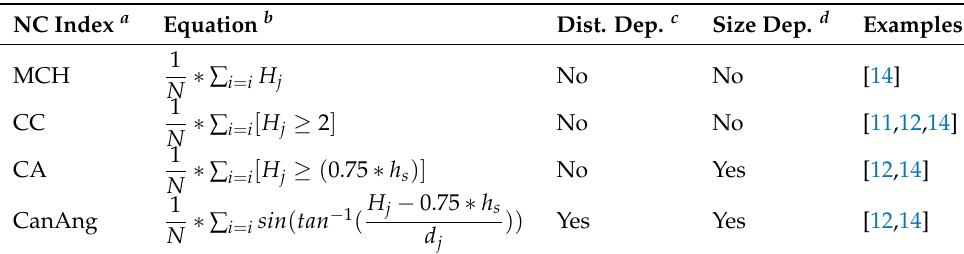
Table 1. Summary of the chosen neighborhood crowding indices, showing equations, distance and size dependence as well as references.